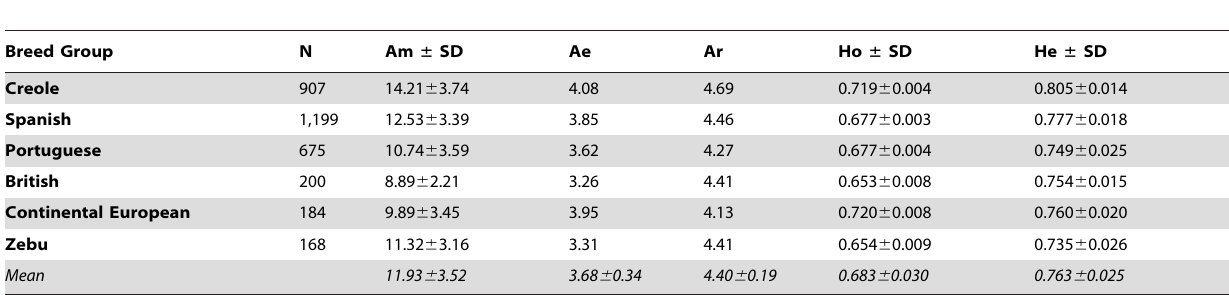
Table 1. Genetic variability estimated for different groups of cattle breeds.